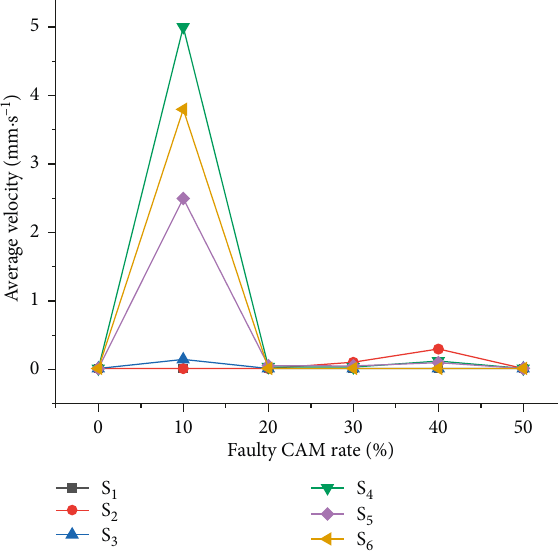
Figure 7: Average velocity with different faulty CAM